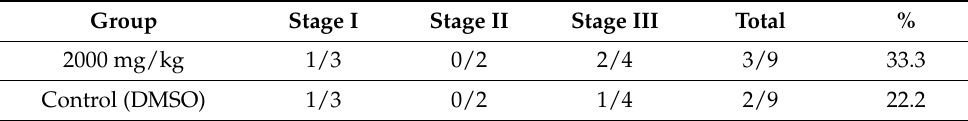
Table 2. Effects of the treatments with different oral doses of the HELTr on the behavioral reactions of zebrafish.